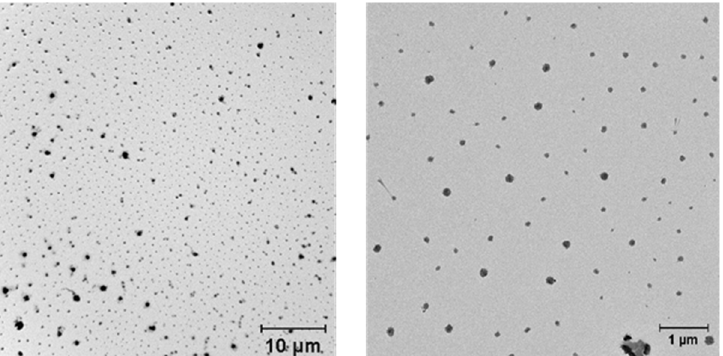
Figure 3. TEM images of the suspensions of the nanomaterial called CaNP 1 , which was produced in the presence of Tween 20 and PEG-2000.